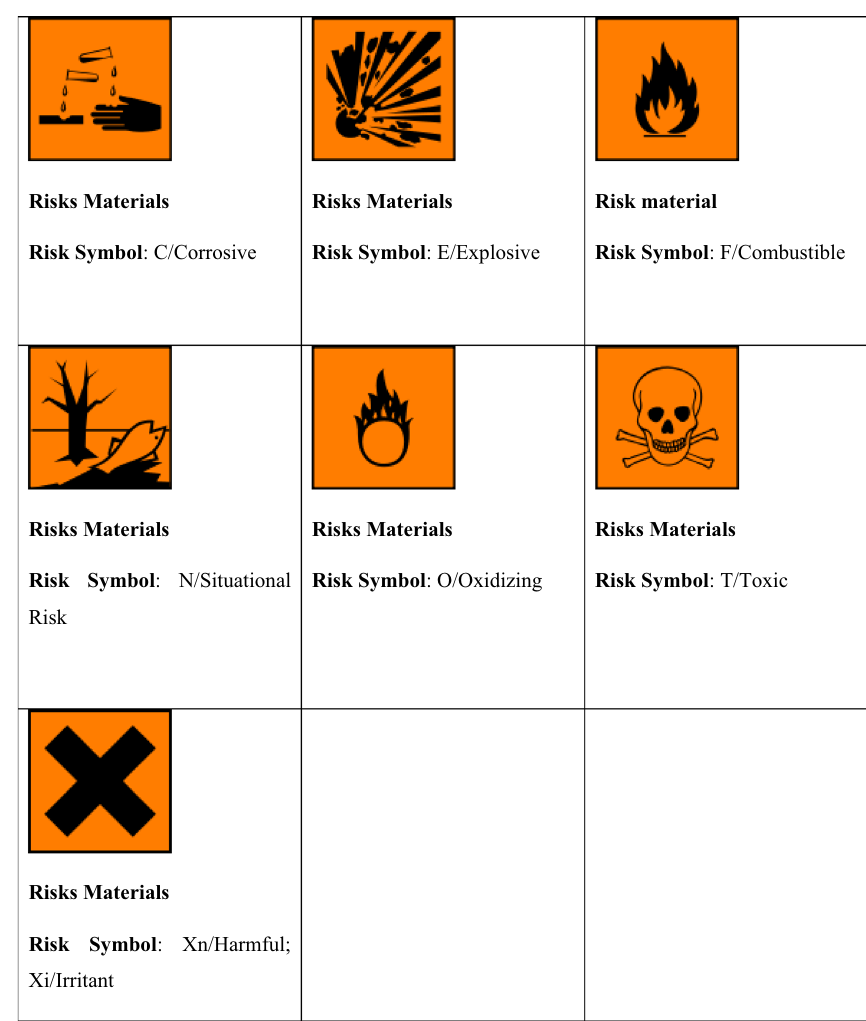
Fig. 8 Globally matched system of classification and labeling of chemicals